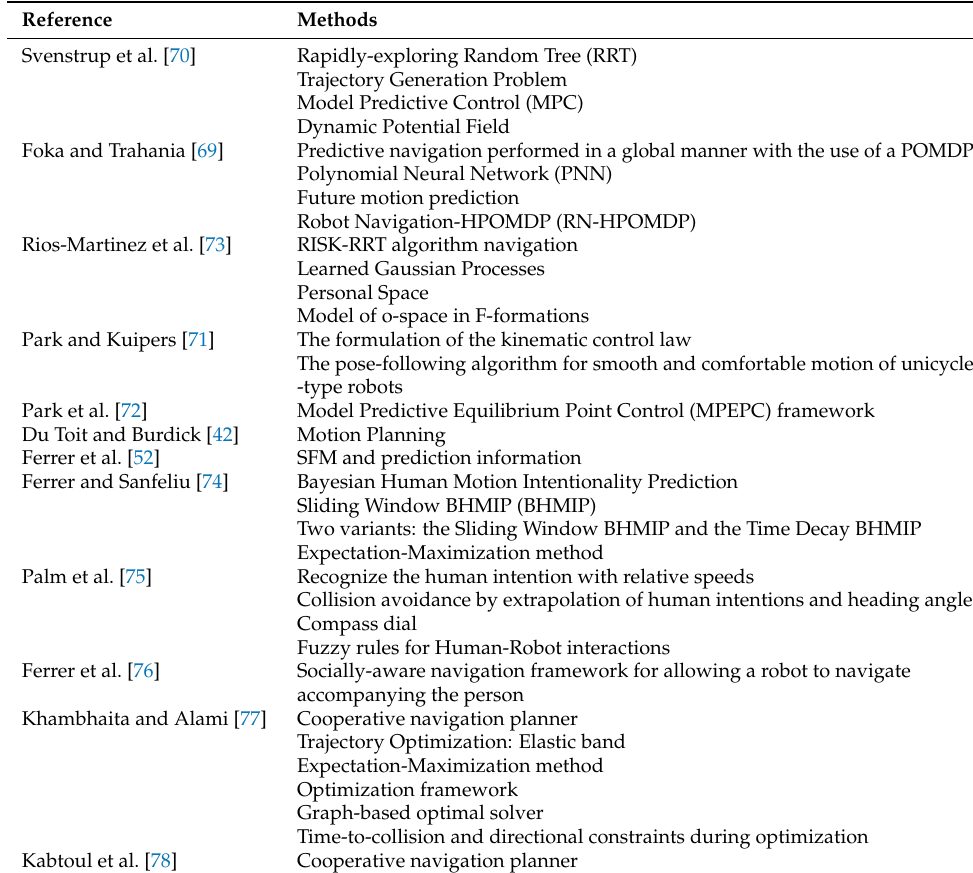
Figure 10. The robot Dabo accompanying a person to the desired goal while navigating in a crowded scenario [74]: ( left ) image captured from the robot camera; ( center ) the robot Dabo; ( right ) the robot GUI. The green cylinders correspond to people and the orange cylinder corresponds to the target. Permission by ELSEVIER 5483750554512. Table 3. Approaches considered in Section 3.2.2. The table covers the methods they use for solving the navigation